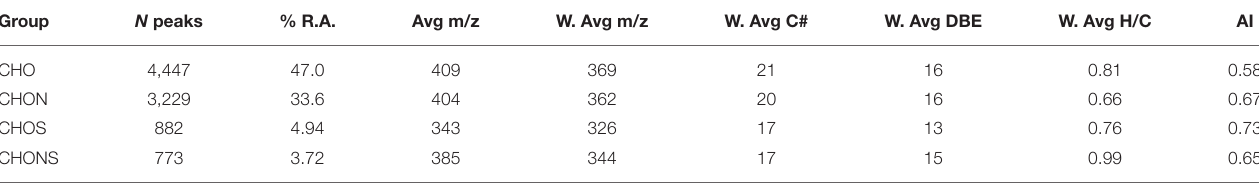
TABLE 1 | Group distribution of Idaho HA FT-ICR MS spectrum after molecular formula assignment. Group N peaks % R.A.